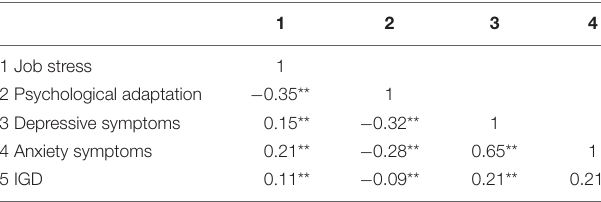
TABLE 3 | Bi-variate correlations between psychological variables and